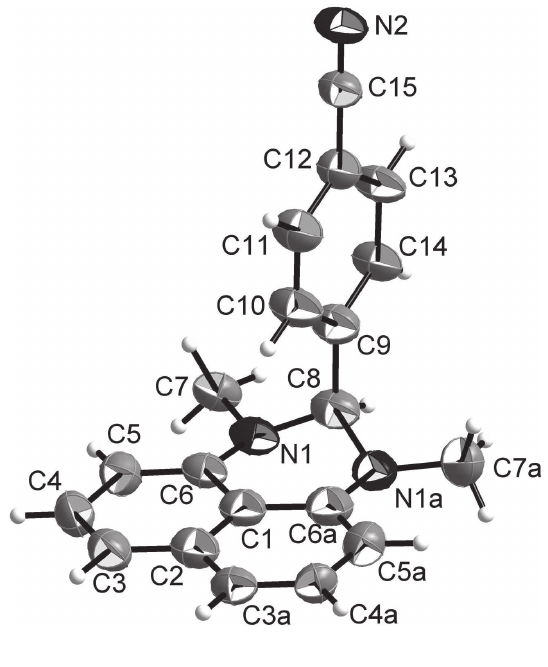
Table 1: Data collection and handling.